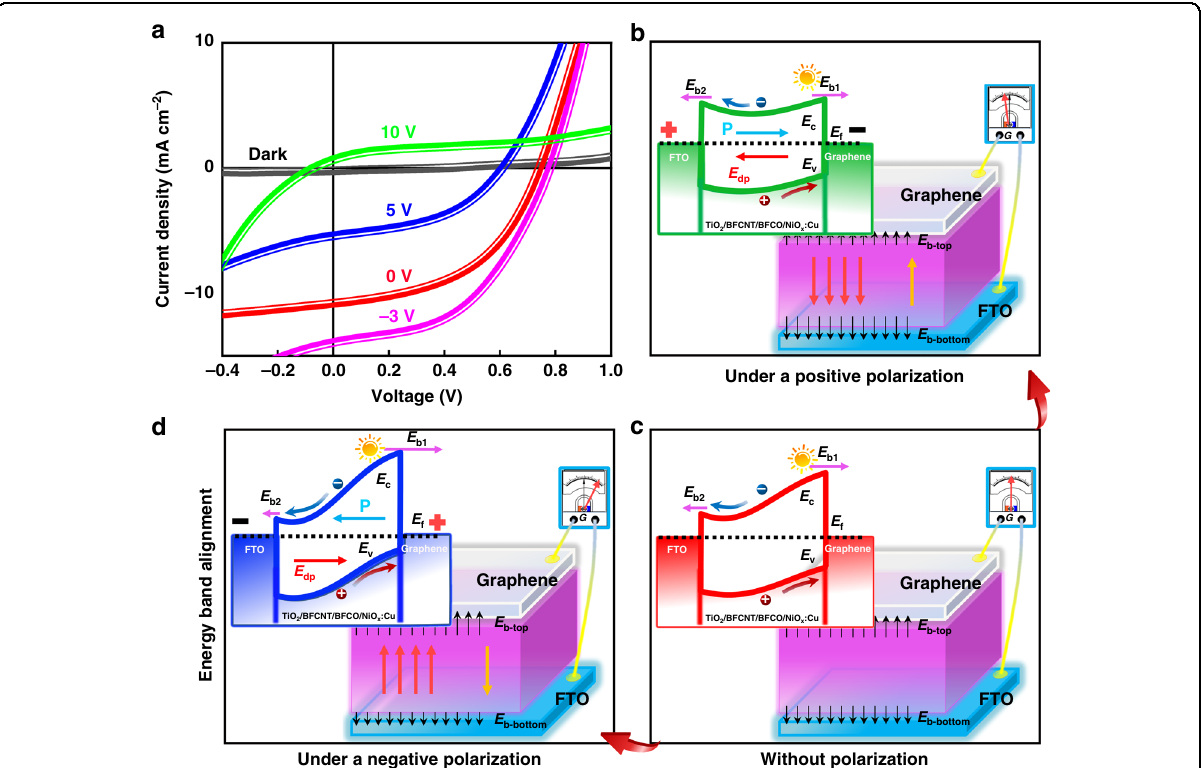
Fig. 3 Modulation of polarization on photovoltaic properties. a J-V characteristics at different polarizing voltages under AM 1.5 G illumination. b – d Schematic of both energy band alignments and the corresponding changes of the built-in electronic fi eld without and with